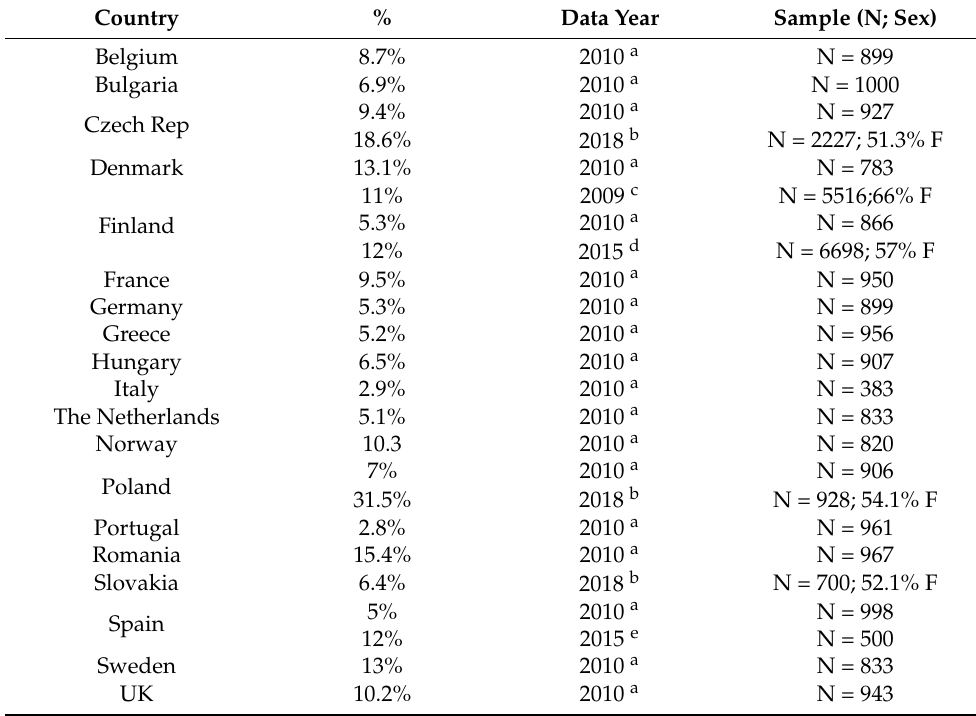
Table 3. Cybervictimization Prevalence by